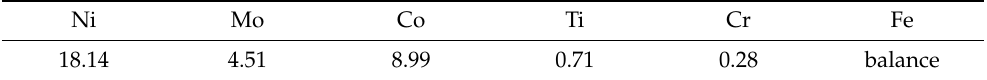
Table 1. The chemical composition of the studied powder based on spectral analysis